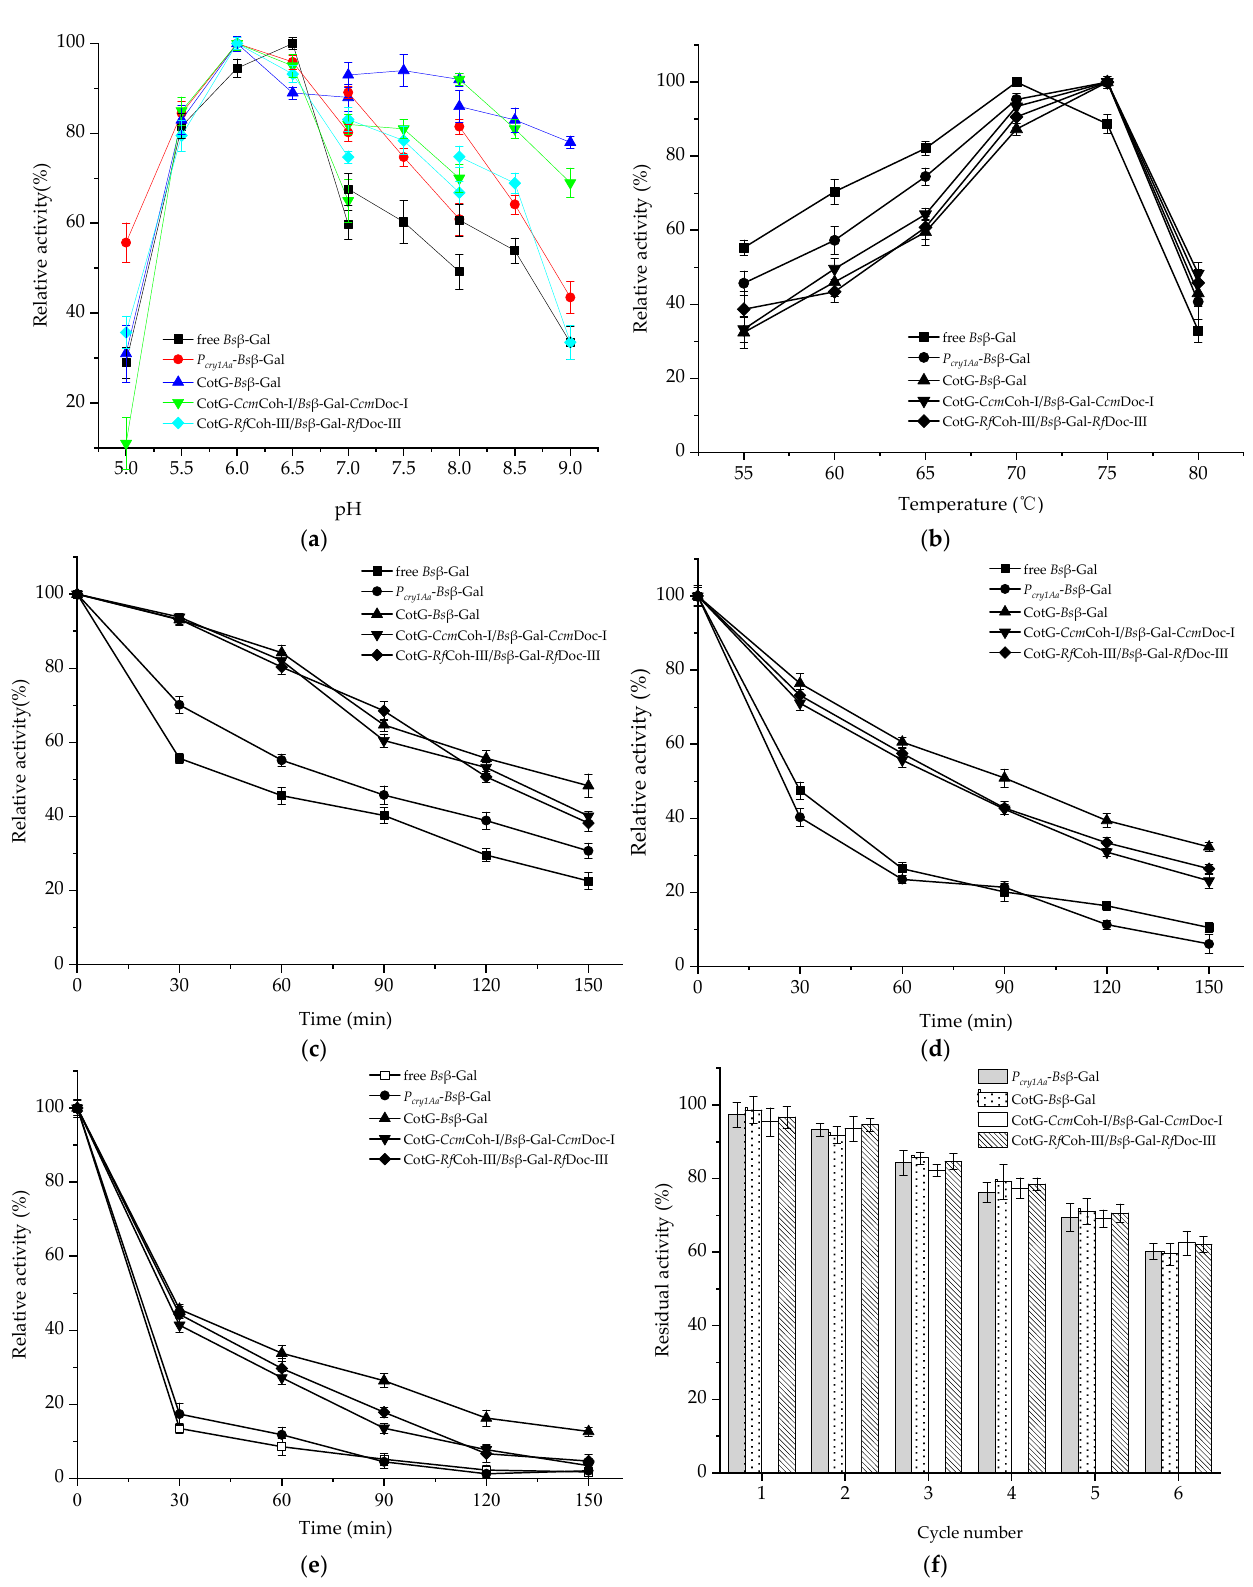
Figure 5. Characterizations of spore-displayed Bs β –Gals. ( a ) Optimum pH of spore-displayed and purified Bs β –Gals. ( b ) The effect of temperature on the activities of spore-displayed and purified Bs β –Gals. Temperature stabilities of spore- displayed and purified Bs β –Gals at 60 ◦ C ( c ), 65 ◦ C ( d ) and 70 ◦ C ( e ), respectively. ( f ) Reusability of spore-displayed Bs β –Gals. The data are the means of three replicates. Error bars represent standard